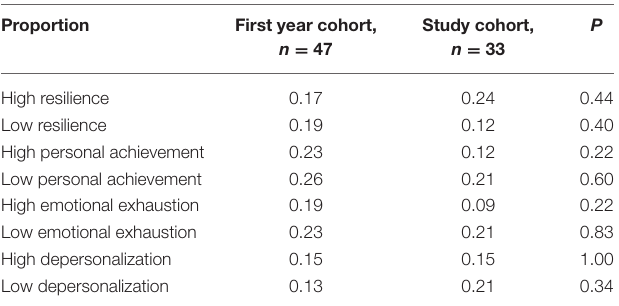
TABLE 3 | Comparison of high and low scorers on burnout and resilience measures across survey takers from the first-year cohort and current study cohort show no significant difference.